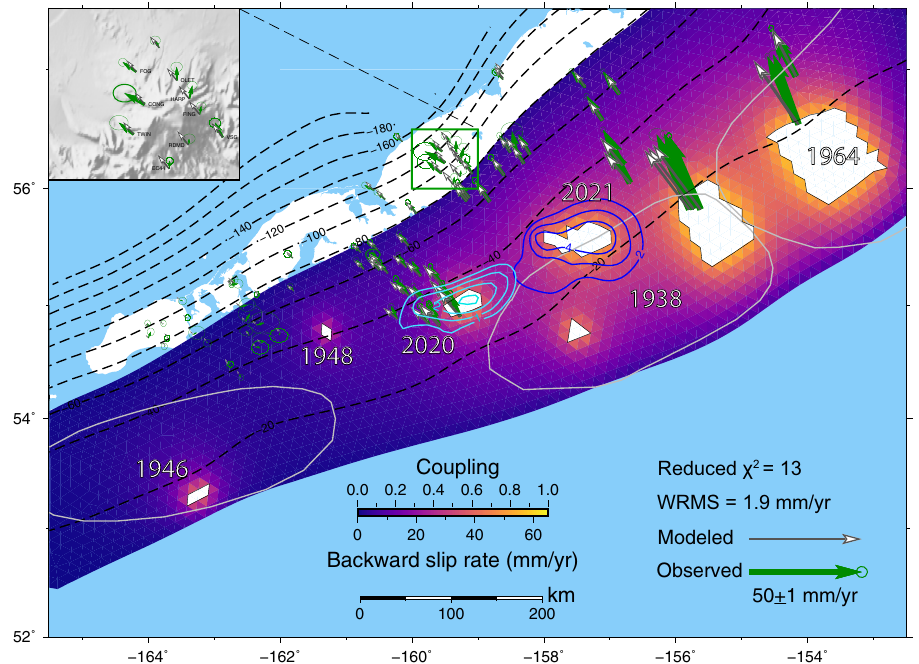
Fig. 5 The preferred interseismic backward slip rate (coupling) distribution in the Alaska subduction zone based on historical and recent rupture zones. Shown in white are locked asperities based on the location of past ruptures with a backward slip rate of 65 mm/yr, equals to the relative plate convergence rate between the Paci fi c plate and North American plate 74 . Note that the 1964 asperity represents only the westernmost of three coseismic slip patches of the Mw 9.1 event 35 . Colors of triangular elements denote backward slip rate (coupling) calculated from the forward Boundary Element Method (BEM) model. Green and gray arrows show the observed and predicted station velocities. Dashed lines depict the depth contours from the Slab2 model 65 . Gray outlines labeled with year are the rupture zones of large historical earthquakes. Light blue and deep blue lines represent the contours (in meters) of the coseismic slip distribution of the 2020 Simeonof and 2021 Chignik earthquakes, respectively. Inset shows the observed and modeled Global Positioning System (GPS) data around Veniaminof volcano (green